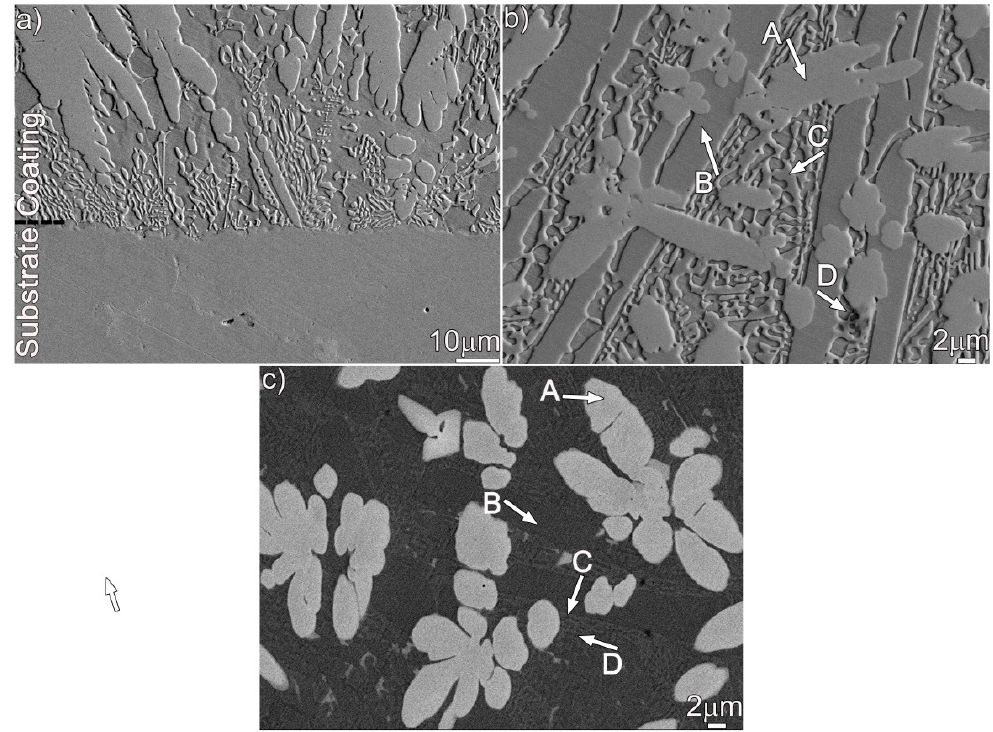
Figure 2. SEM secondary electron images ( a , b ) and backscattered electron image ( c ) showing the microstructure in the coating: ( a ) at the interface and ( b , c ) at the upper part.